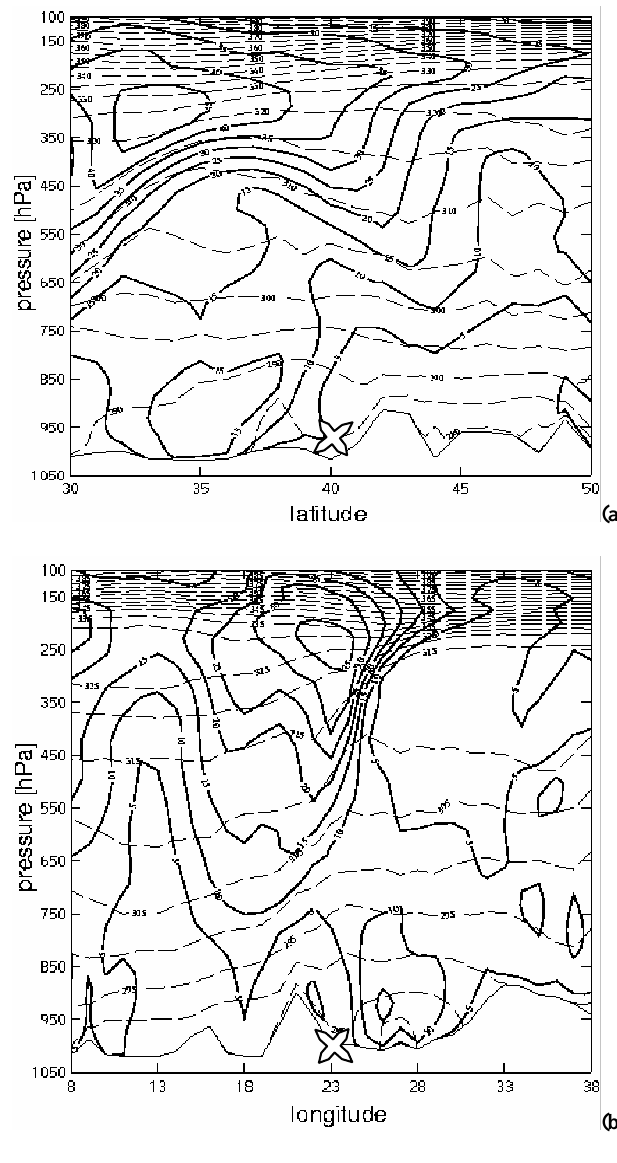
Fig. 7. (a) Vertical cross section of potential temperature (K) over Thessaloniki for 29 November 2000 at 18:00 UT, along the south-north direction (latitudes form 30 ◦ to 50 ◦ N) (Thessaloniki is marked by X). (b) Vertical cross section of potential temperature (K) over Thessaloniki for 29 November 2000 at 18:00 UT, along the west-east direction (longitudes form 8 ◦ to 38 ◦ E) (Thessaloniki is marked by